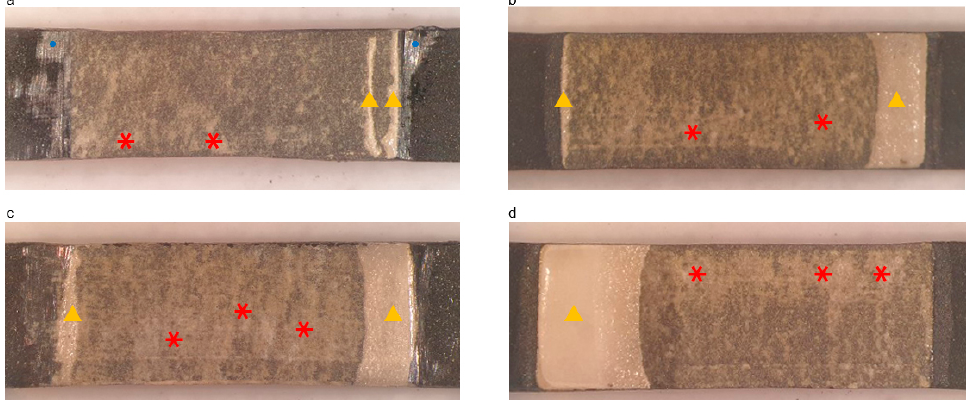
Figure 6. Optical microphotographs of Co-Cr alloy surfaces after de-bonding with ceramic (magnification 8 × ). ( a ) Casted specimen; ( b ) SLM-fabricated specimen without bonding agent; ( c ) SLM-fabricated specimen with bonding agent A; ( d ) SLM-fabricated specimen with bonding agent B. Yellow triangles represent adherent ceramic, and red asterisks indicate remnant wash opaque. Blue circles indicate remnant sputtered Au.